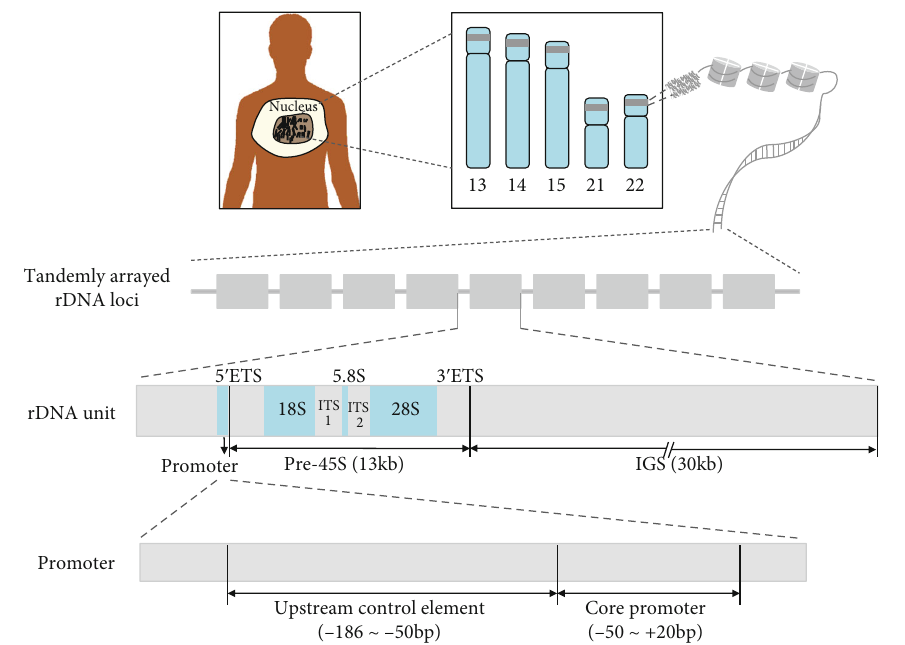
Figure 1: Structural organization of the rDNA clusters in the human genome showing the tandem arrangement of the multiple rDNA copies (above) and organization of each individual rDNA unit (middle) and the promoter region (bottom). ETS: external transcribed spacer; ITS1/2: internal transcription spacer 1/2; IGS: intergenic spacer. The promoter structure was redrawn from